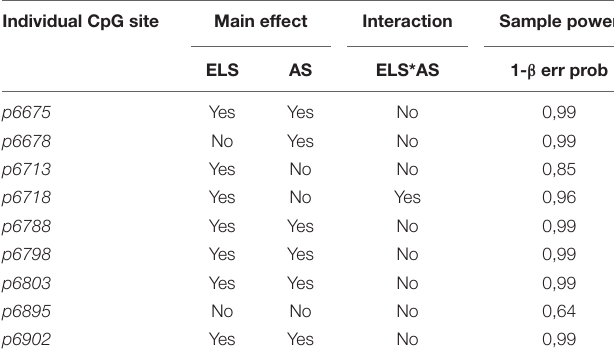
TABLE 2 | Two-way ANOVA results for individual CpG site-specific DNA-methylation within the Y2 receptor gene promoter in male animals. Individual CpG